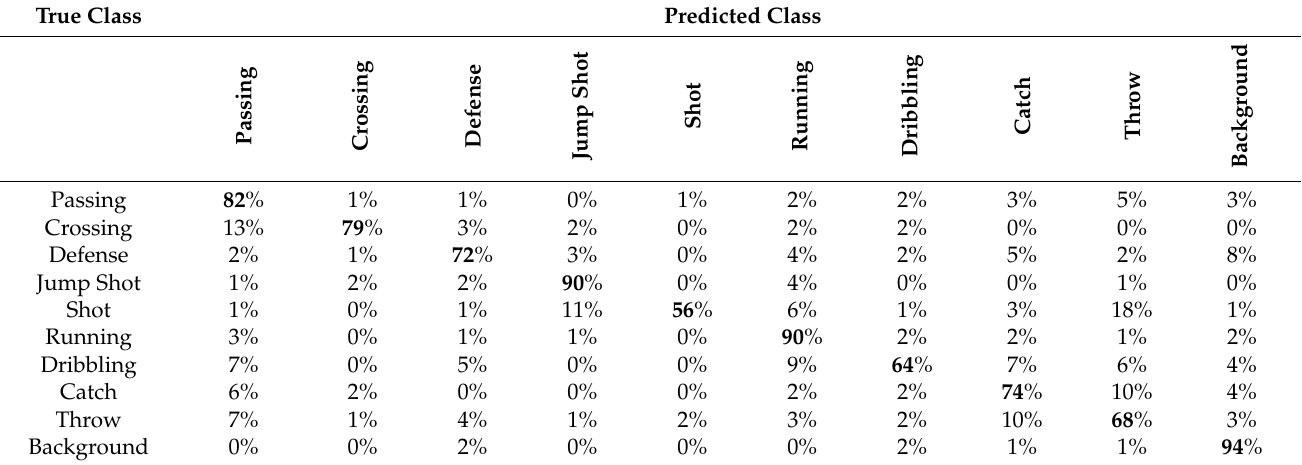
Table 4. Confusion matrix for the I3D_40D model that uses decimation strategy and 40 input frames. The values in bold represent the percentage of samples for which the predicted label is true positive (equal to the ground-truth